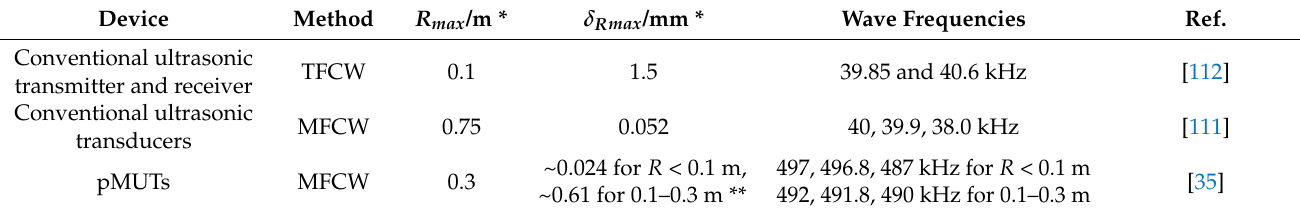
Table 7. Summary of rangefinders with continuous wave methods.